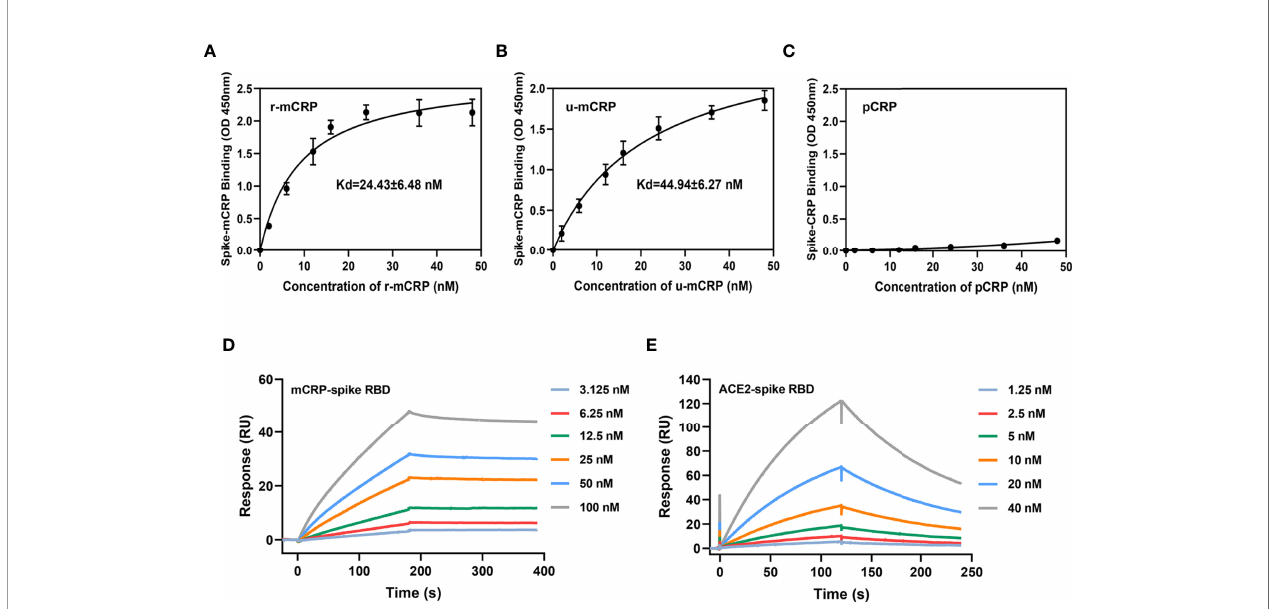
FIGURE 1 | Binding of monomeric C-reactive protein (mCRP) to the spike receptor-binding domain (RBD). Different concentrations of (A) recombinant mCRP (r- mCRP) (n = 3), (B) urea-denatured mCRP (u-mCRP) (n = 3), and (C) pCRP were added to spike RBD-immobilized microtiter wells. Binding was detected with the mCRP-speci fi c mAb 3H12 or the pCRP-speci fi c mAb 8D8. mCRP obtained in different ways showed strong binding to the spike RBD, whereas pCRP did not (n = 3). (D) Surface plasmon resonance (SPR) assays to detect the binding of mCRP to the spike RBD. mCRP was injected in the fl uid phase into spike RBD-conjugated to CM5 chips. CM5 chips without spike RBD conjugation were used as controls. Dose-dependent binding was observed with mCRP. (E) SPR assays to detect the binding of angiotensin-converting enzyme 2 (ACE2) to spike RBD. The binding of spike RBD to ACE2 was detected using SPR to determine the biological activity of spike RBD protein used in the binding experiment. All results are presented as means ±